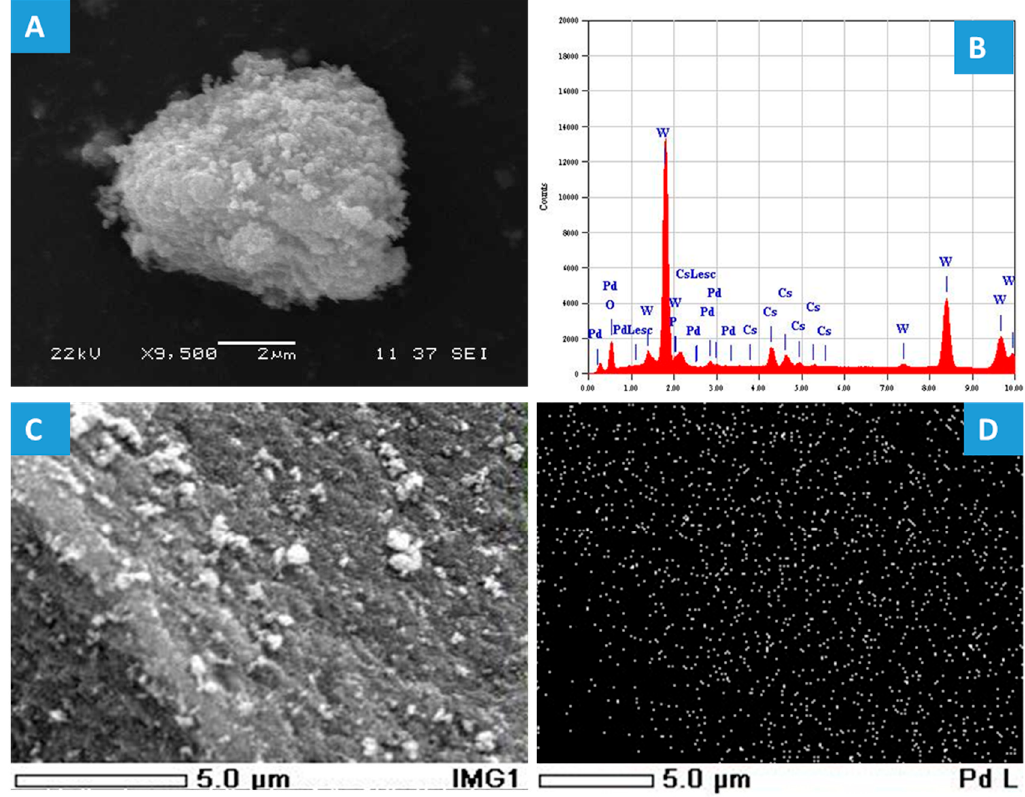
Figure 3. ( A ) Scanning electron microscope (SEM) micrograph of Pd-CsPW particle, ( B ) The corresponding energy-dispersive X-ray spectroscopy (EDX) analysis of Pd-CsPW, ( C ) SEM micrograph of Pd-CsPW surface, and ( D ) Mapping of Pd nanoparticles throughout the Pd-CsPW